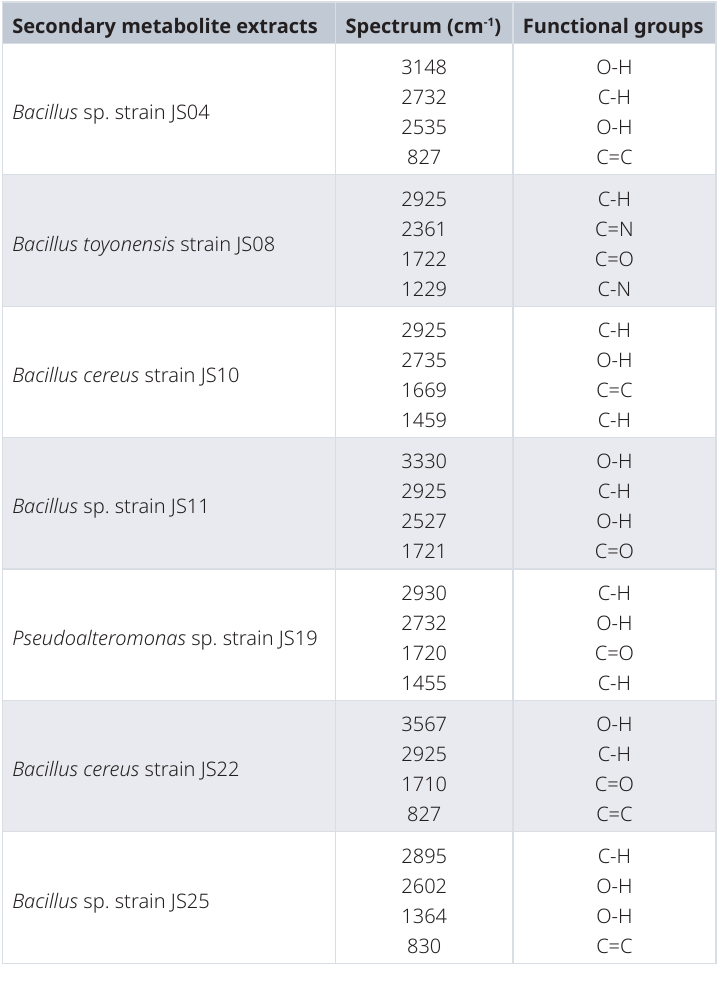
Table 2. Inhibitory activity in the secondary metabolite extracts of heterotrophic bacteria against pathogenic bacteria. Mean values with different superscripts in the same columns were significantly different (p <